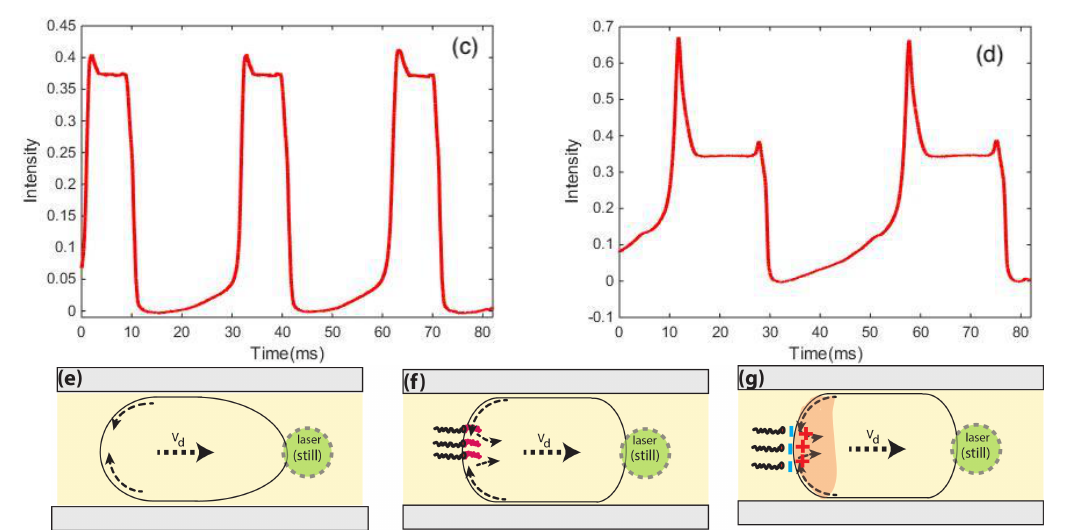
Figure 4. Fluorescence signal from microdroplets ( a ) in HFE7500–without surfactant; ( b ) with surfactant KryJeffa; ( c ) droplets stabilized in Krytox (size around 125 µ m); ( d ) big droplets with surfactant Krytox (size above 250 µ m); ( e ) plug-like deformation of a large droplet induced by flow of viscous oil; ( f ) heterogeneous distribution of surfactant at the droplet interface; ( g ) in the case of Krytox the distribution of surfactant and its corresponding interaction to charged rhodamine molecules at the rear of the